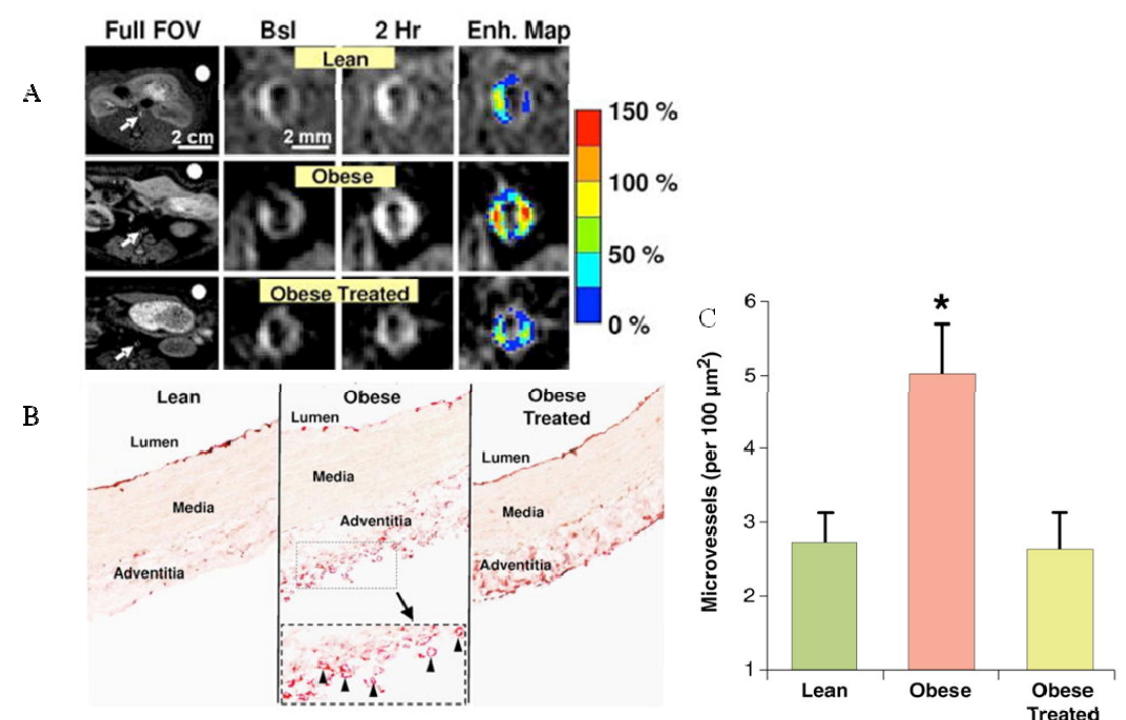
Figure 10. ( A ) In vivo MRI of neovascularization 2 hours after injection of avb3-binding paramagnetic nanoparticles in lean, obese and obese treated mice. Contrast enhancement was increased in obese mice and was reduced to normal levels (of lean mice) after treatment with the appetite suppressant, benfluorex. ( B ) Staining of von Willebrand factor shows high density of neovessels in the adventitia of obese mice. ( C ) Quantification of adventitial microvessel density demonstrates a more than two fold increase in obese mice and a normalization after benfluorex treatment (adapted from Winter)